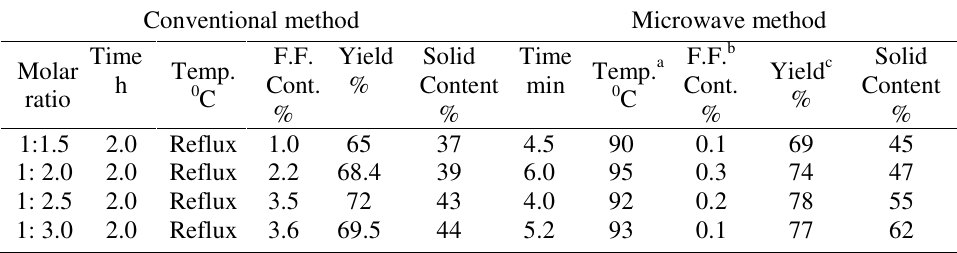
Table 1. Comparative study for the synthesis of phenol-formaldehyde